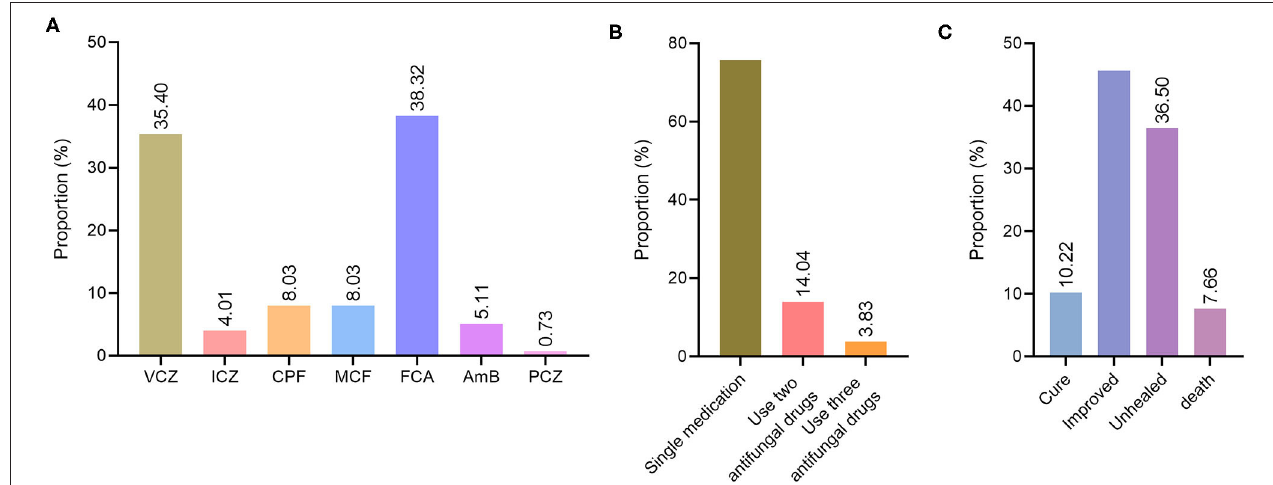
FIGURE 3 | Treatment and prognosis of deep fungal infections. (A) Distribution diagram of antifungal drug species for deep fungal infections. VCZ, voriconazole; ICZ, itraconazole; CPF, caspofungin; MCF, micafungin; FCA, fluconazole; AmB, amphotericin B; PCZ, posaconazole. (B) Distribution of antifungal drug use patterns in patients with deep fungal infections. (C) The distribution of prognostic types for deep fungal infections.